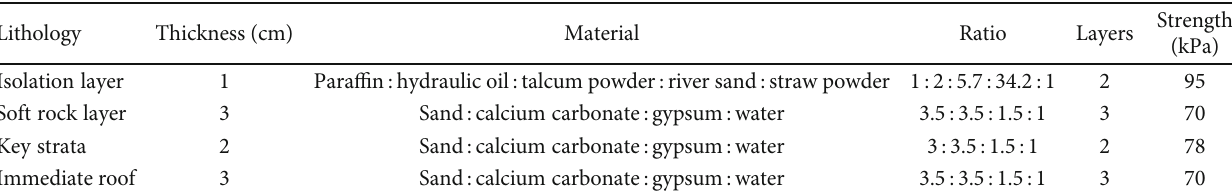
Figure 4: Schematic of experimental system used for the emulation. Table 1: Model laying